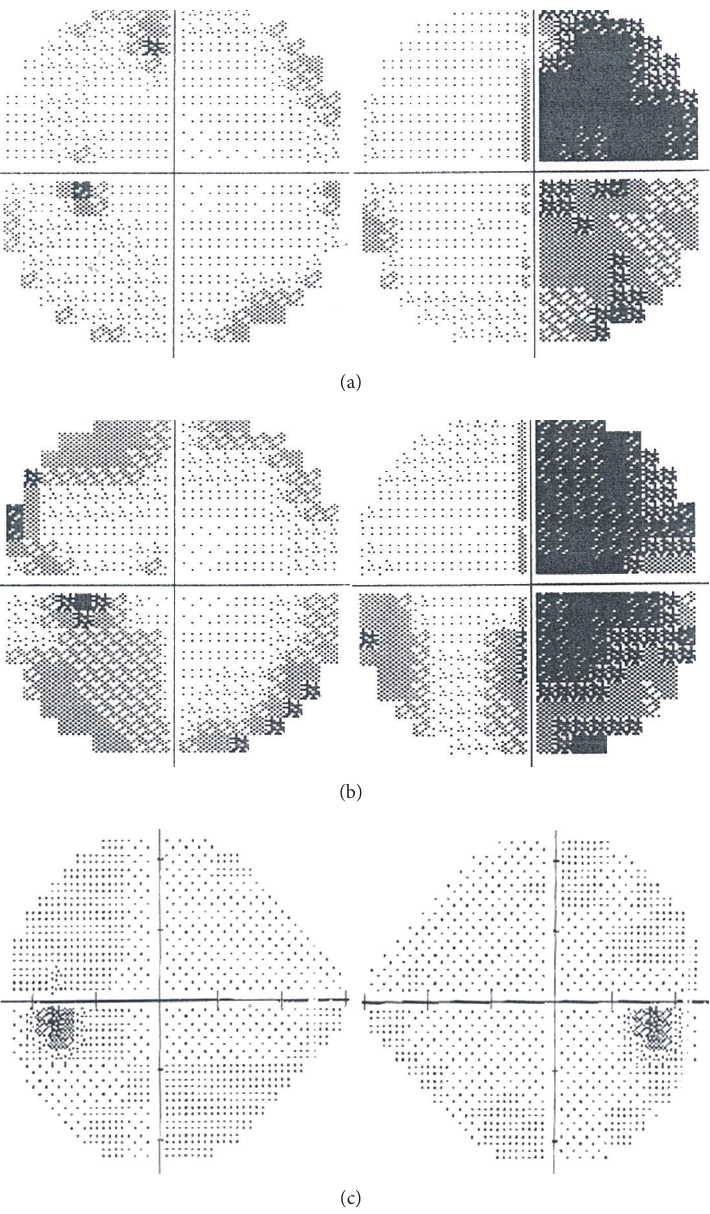
Figure 1: Onset (a), preoperative (b), and postoperative (c) visual